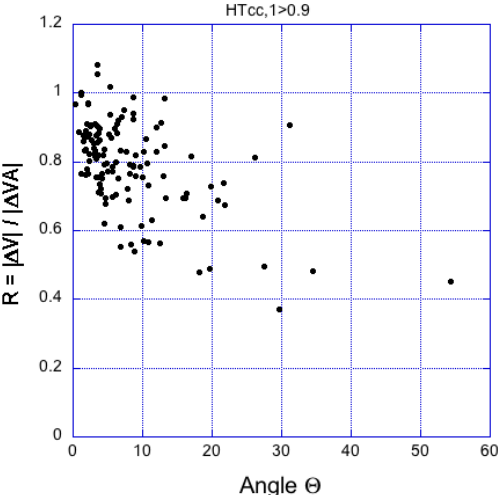
Fig. 9. Scatterplot of the R = | 1 v /1 V A | ratios and angles 2 be- tween 1 v and 1 V A for the cases with HT cc , 1 ≥ 0.9, based on the 1min intervals to the left and right of the